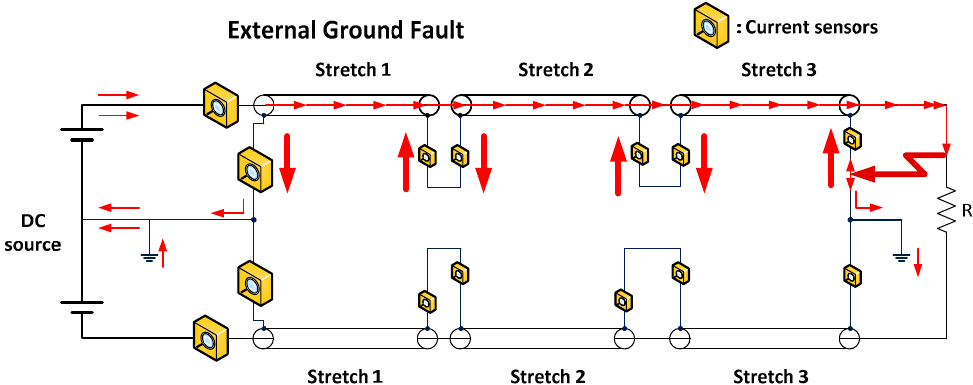
Figure 7. Current circulation for an external ground fault outside of the cable.